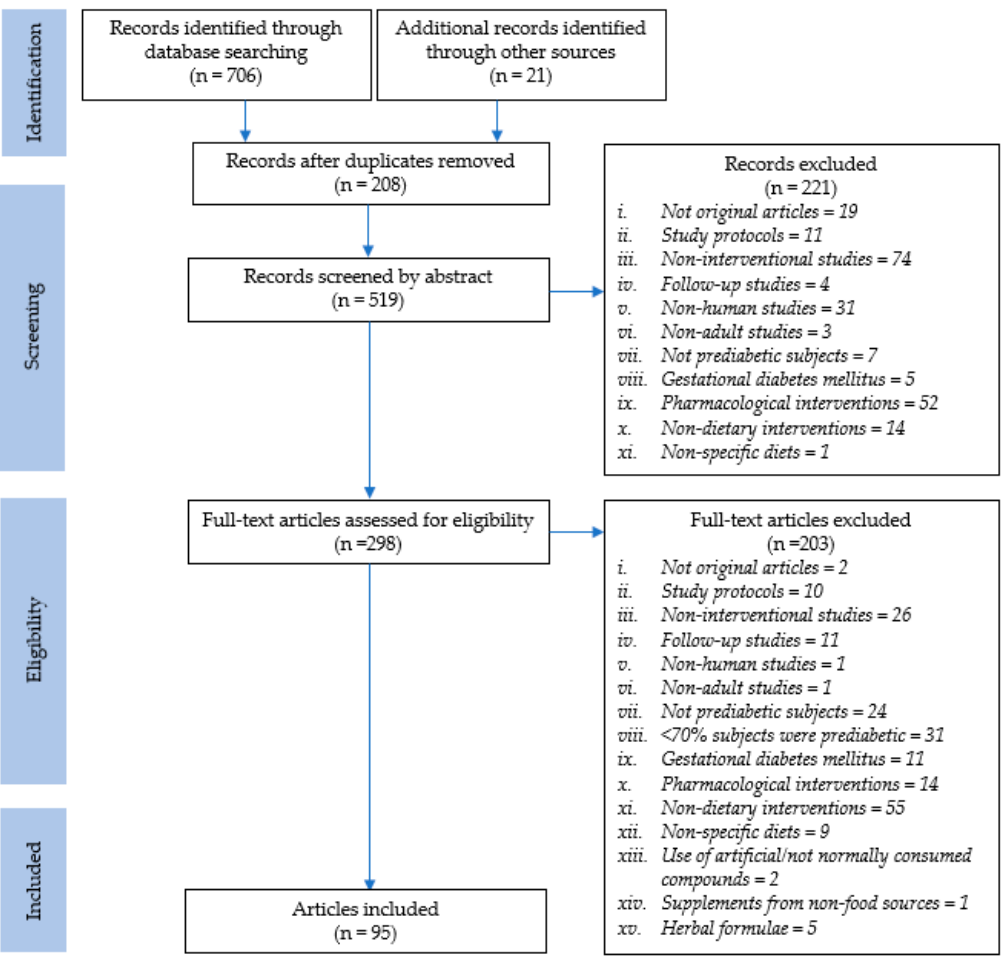
Figure 1. Preferred Reporting Items for Systematic Reviews and Meta-Analyses (PRISMA) flow chart depicting the literature search and study selection process. Nutrients 2020 , 12 , x FOR PEER REVIEW